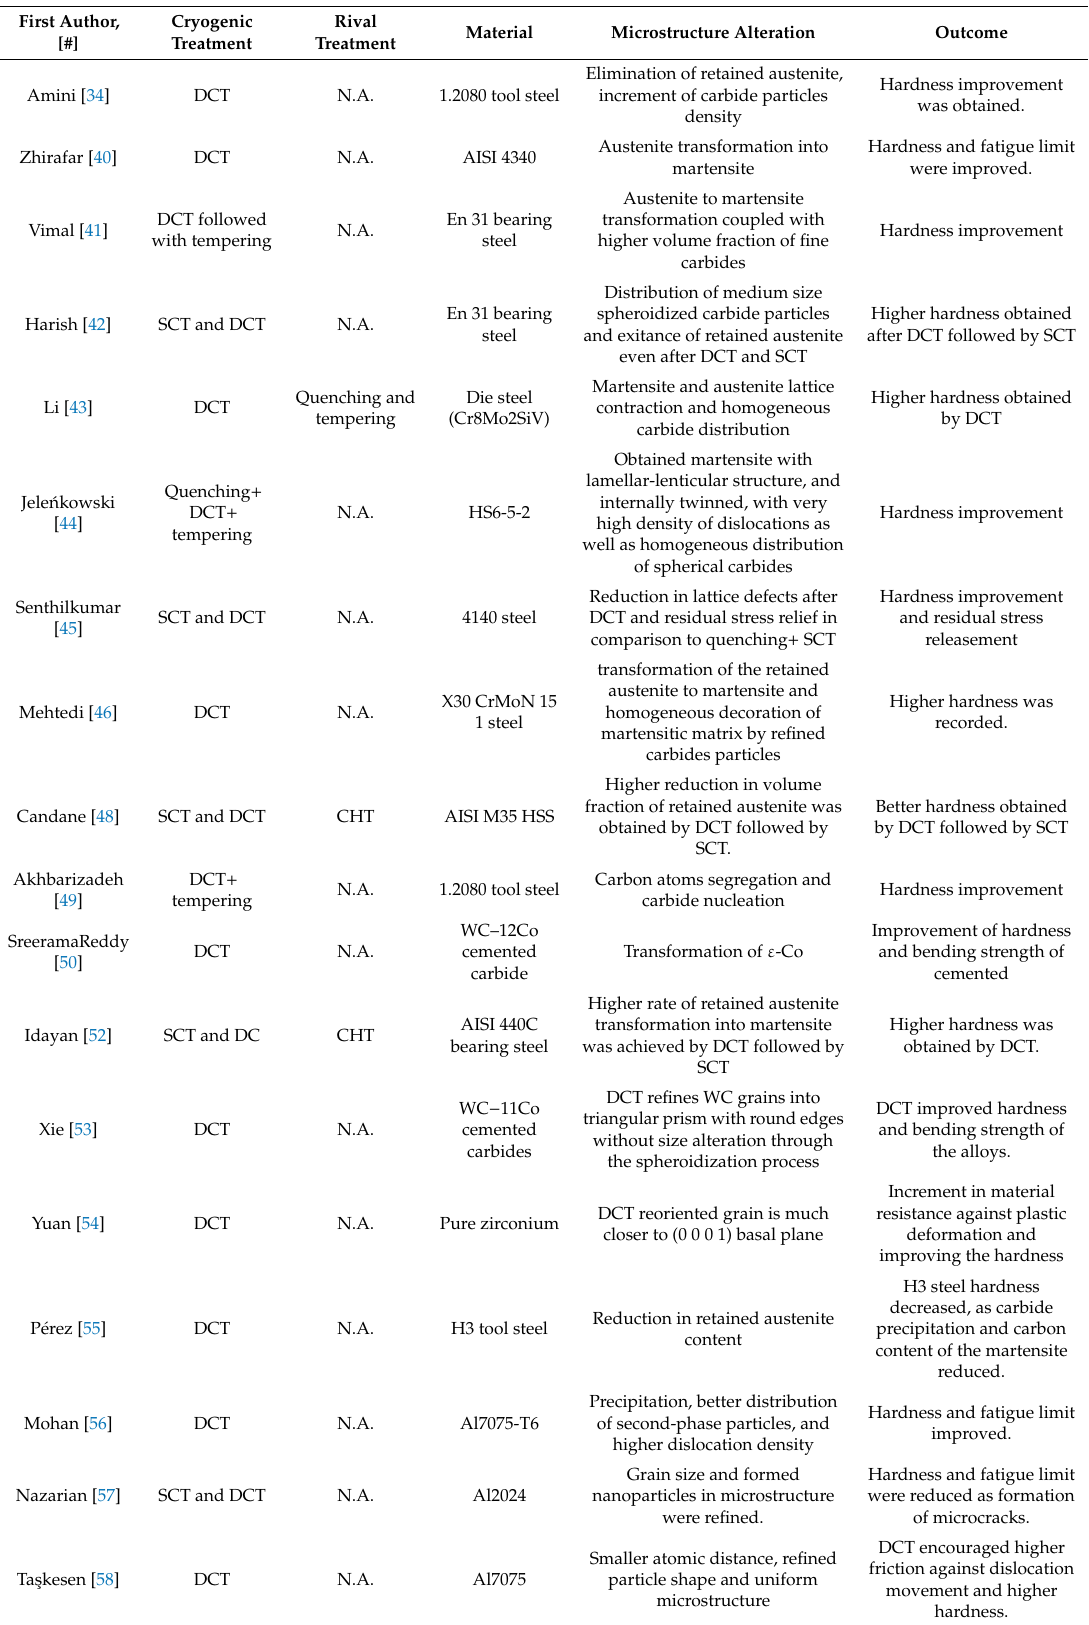
Table 1. Summary of literature data devoted to studying the e ff ects of cryo-treatment on microstructure and